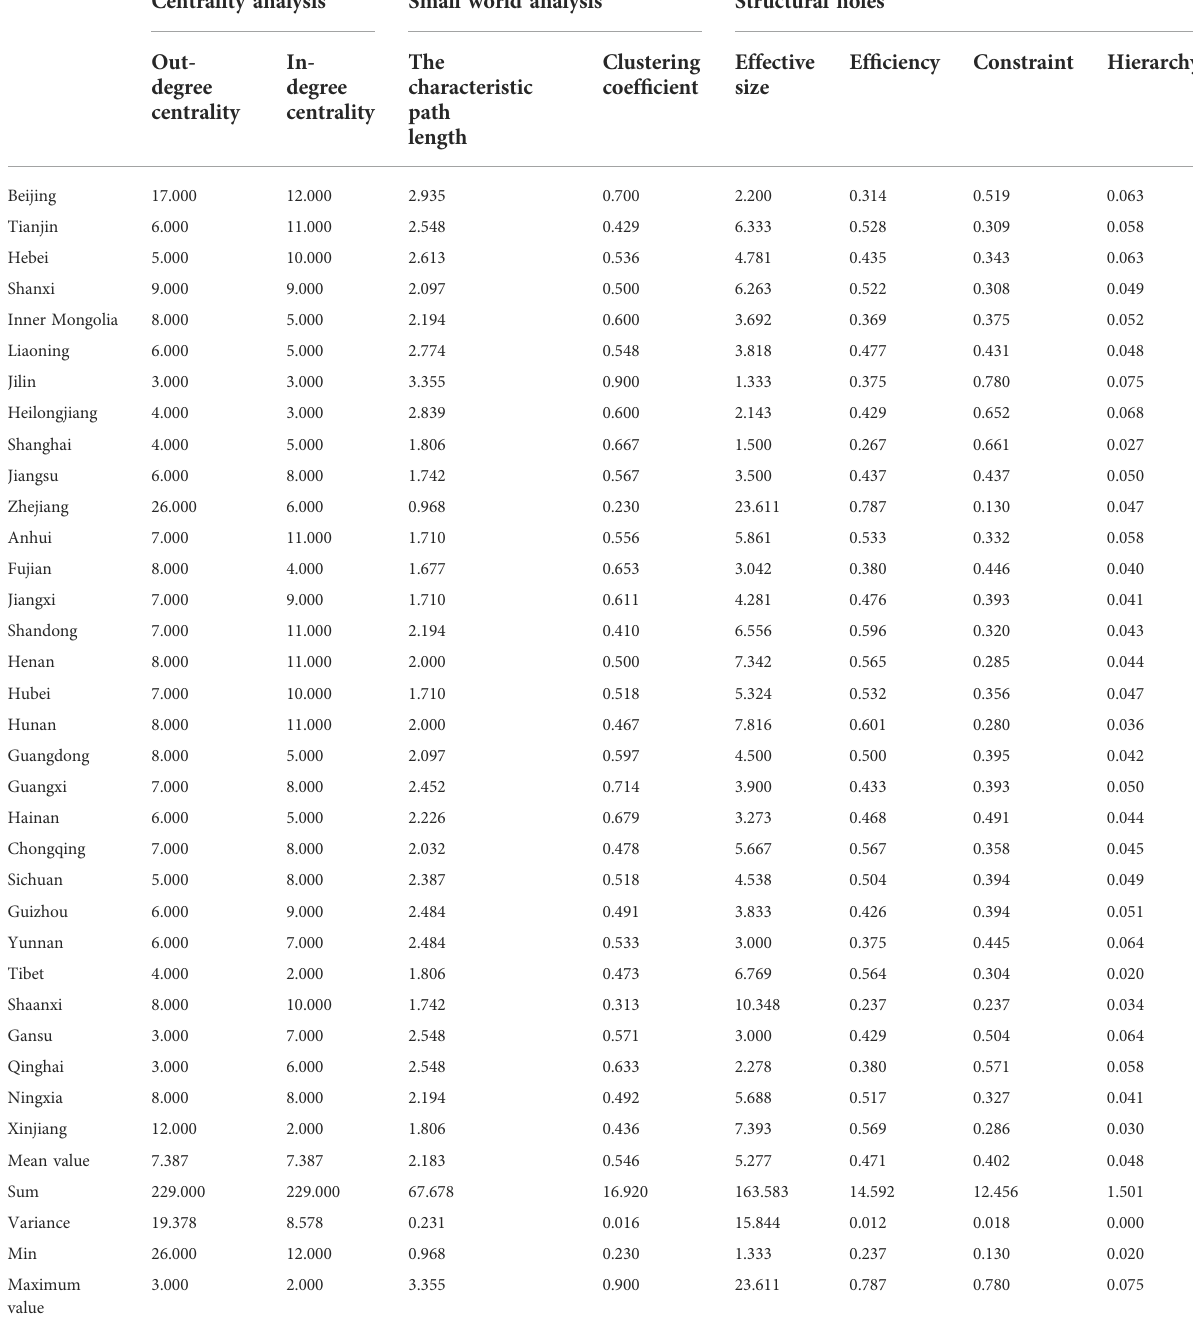
TABLE 3 Individual network characteristics of the impact of green fi nancial development on industrial structure